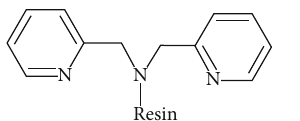
Figure 4: Structure of the bis-pyridylmethyl amine functional